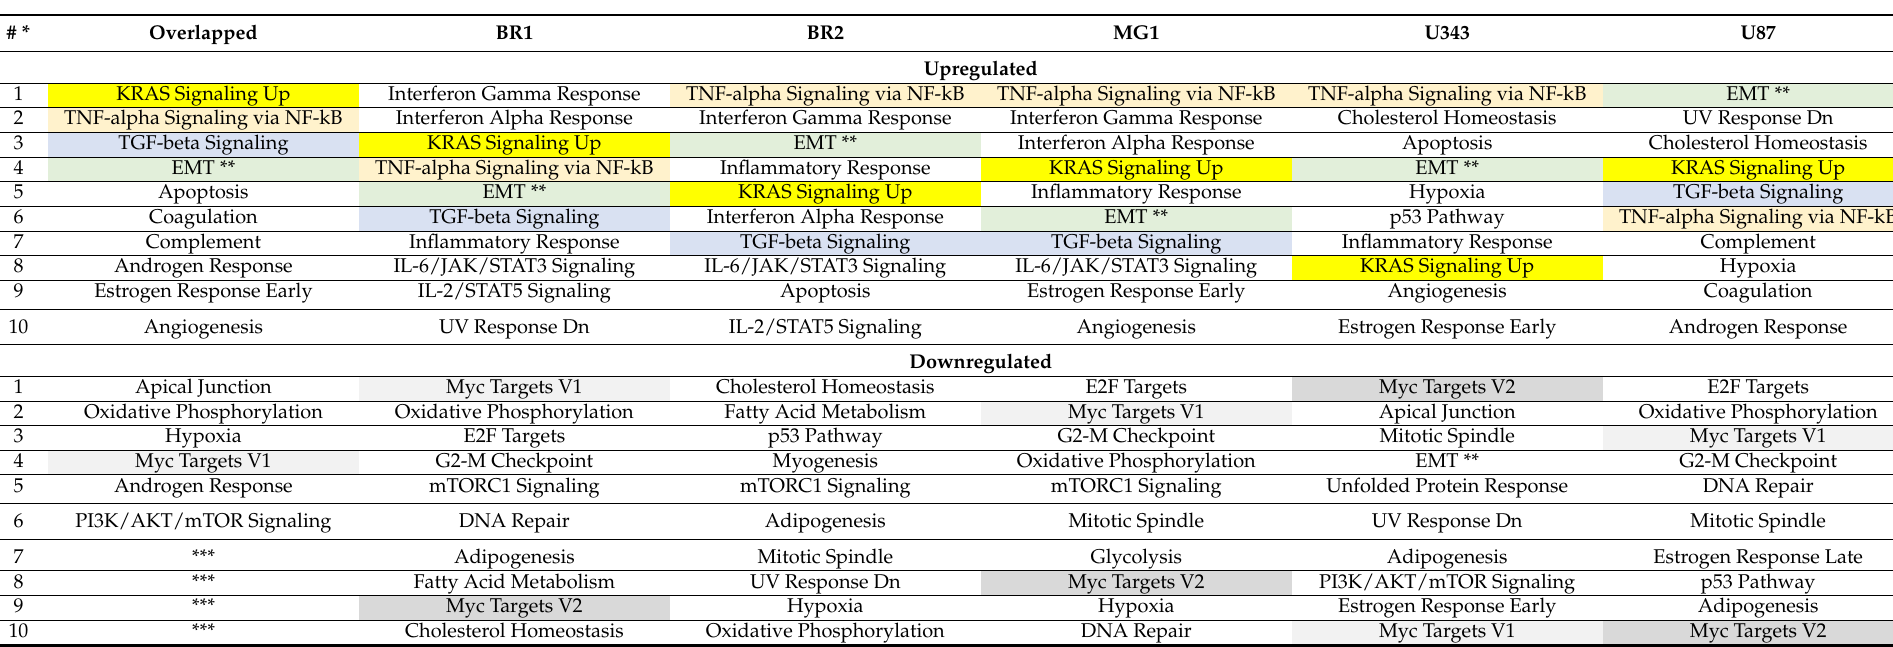
Table 4. Cellular processes and signaling pathways. Essential cellular processes and signaling pathways of NS formation determined using Enrichr. Top 10 Enrichr records (library “MSigDB Hallmark 2020”), ordered by descending p - value (with adjusted p -value < 0.05), for each particular MN/NS pair, as well as for the list of overlapping up/downregulated genes. Common processes and signaling pathways are highlighted in